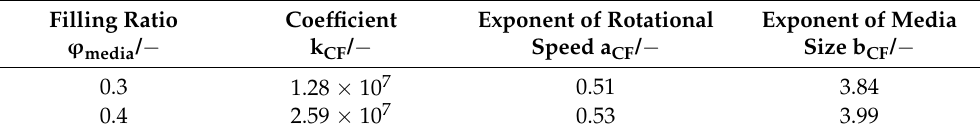
Table 9. Variables for model equation (Equation (16)) to describe the collision frequency based on rotational speed n (in min − 1 ) and media size d media in